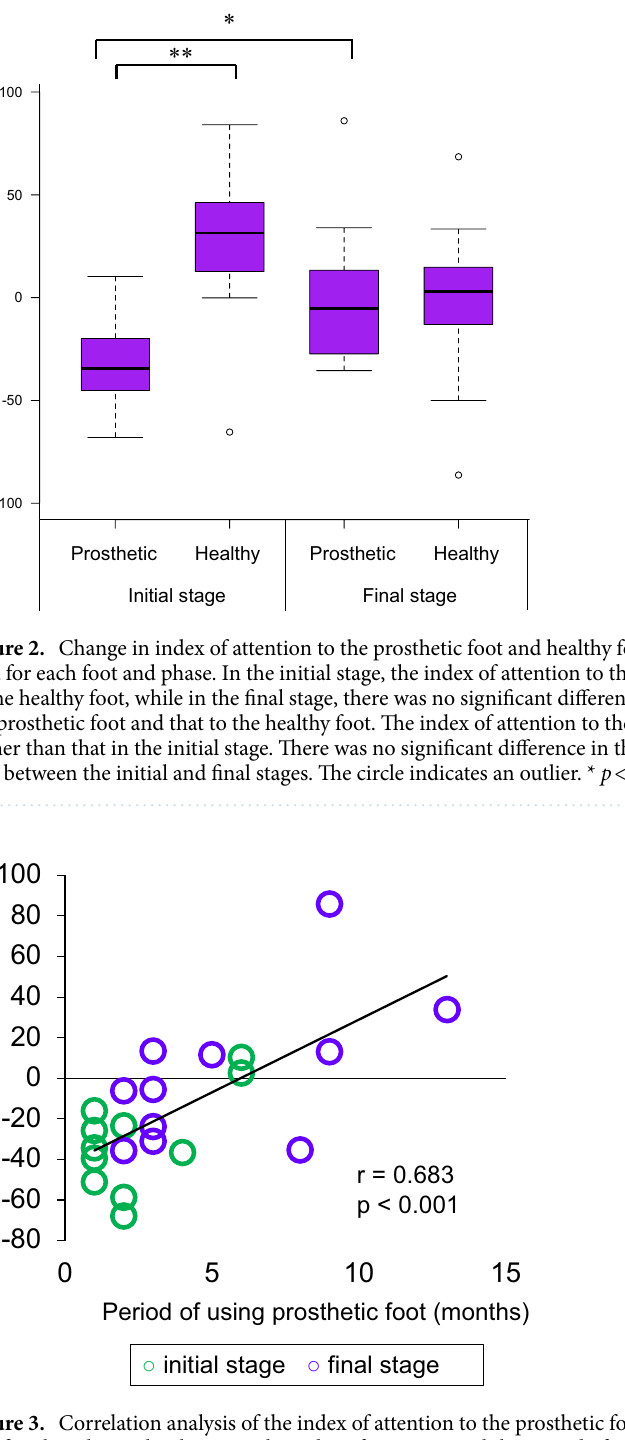
Figure 3. Correlation analysis of the index of attention to the prosthetic foot: initial and final stages. This figure clarifies the relationship between the index of attention and the period of using the prosthetic in the initial and final stages. The index of attention to the prosthetic foot was positively correlated with the period of using the prosthetic foot (r = 0.683, p < 0.001). Individual patients are represented by circles, with the green circle representing the initial stage ( N = 11) and the purple one the final stage of rehabilitation ( N =